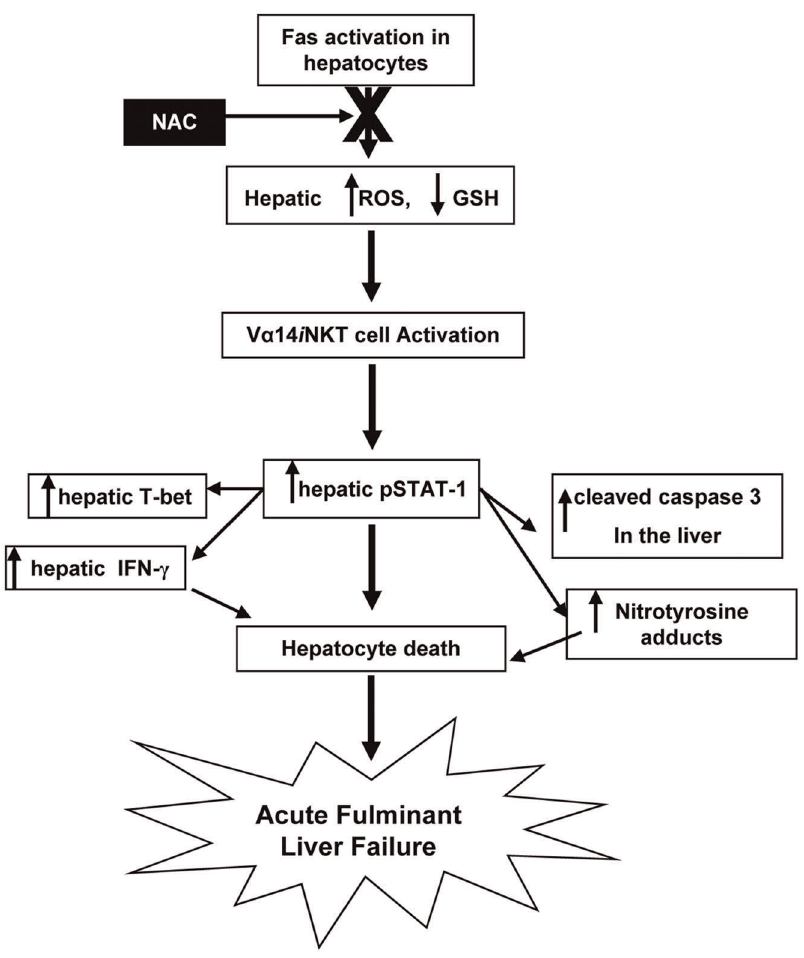
Figure 5. A proposed model depicting the sequential molecular and cellular events of NAC therapy regulation of V a 14 i NKT cells signaling in the liver during Fas mAb-induced FLF. An endogenous mediator inhibited by NAC (possibly ROS) mediates Fas mAb-dependent FLF by promoting intrahepatic V a 14 i NKT cells signaling, upregulation of pSTAT-1 and pSTAT-1-regulated genes, caspase 3 and T-bet, induction of hepatocyte damage and fatal/lethal immunopathological events in the liver that ultimately leads to FLF.